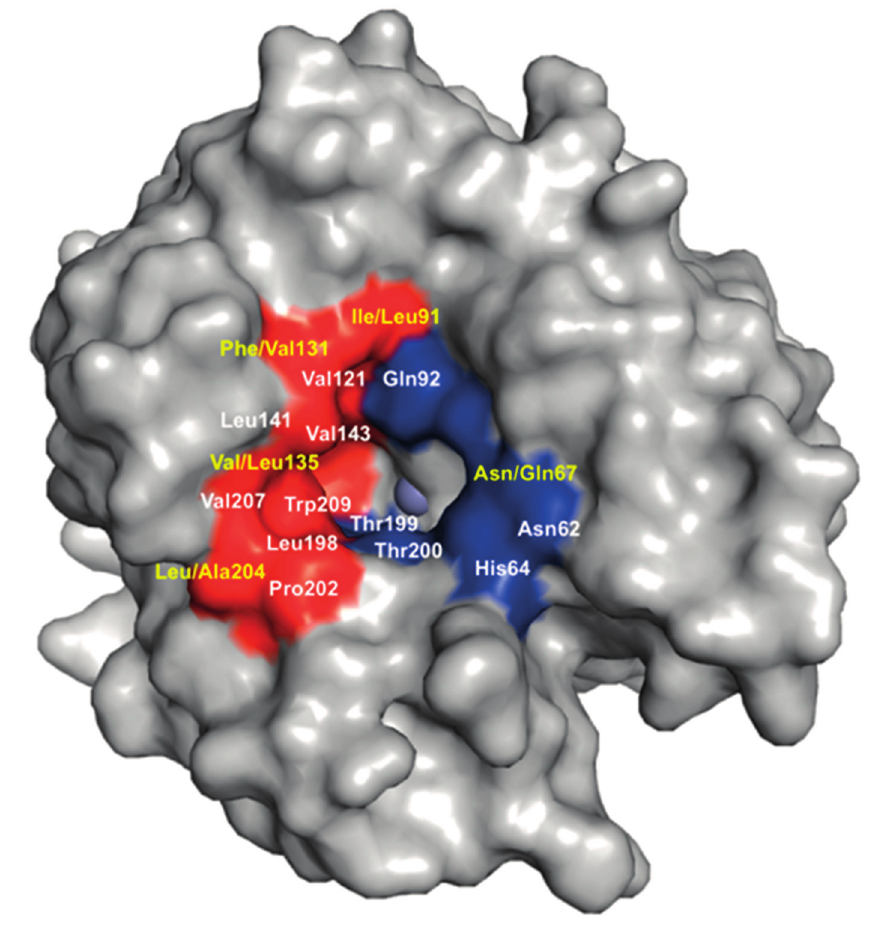
Figure 3. Surface rendition of CA IX (PDB ID: 3IAI). Residues in the hydrophobic (red) and hydrophilic (blue) cleft are as labeled; residues conserved (white) and those that differ (yellow) between CA II and CA IX. Figure made using PyMol